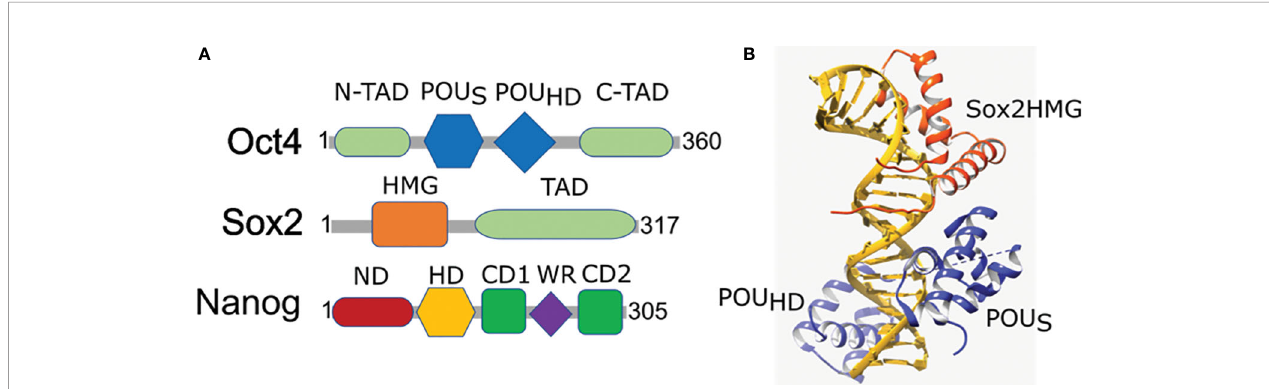
FIGURE 2 | Domain organization and structural arrangement of Oct4, Sox2, and Nanog. (A) Oct4 has DNA-binding domains (a POU-speci fi c DNA-binding domain (POU S ) and a POU-homeodomain (POU HD )) interacting independently with DNA as well as transactivation domains located N-terminal (N-TAD) and C-terminal (C- TAD). Sox2 is a High mobility group (HMG) family member and has a single HMG DNA-binding domain and a transactivation domain (TAD). Nanog has N-terminal containing a DNA-binding homeodomain (HD) and an N-terminal domain (ND), C-terminal containing a dimerization domain (blue) referred to as the tryptophan repeat (WR), that separates C-terminal domain 1 (CD1) from C-terminal domain 2 (CD2). (B) Ternary structure of Oct – Sox – DNA (PDBID: 1O4X). Sox2 binding to DNA and Oct4 is enabled by the HMG domain (orange) that cooperates in binding of Oct4 POU domain (blue) onto the DNA (golden).